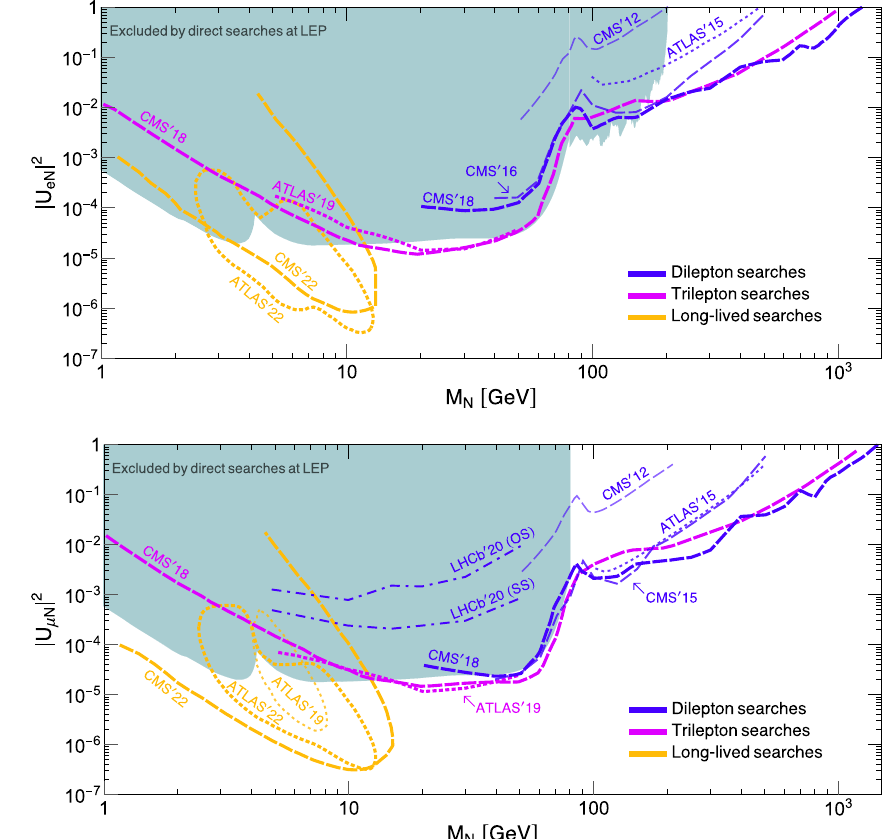
Fig. 2 Summary of direct HNL searches performed at the LHC so far, either by CMS (dashed), ATLAS (dotted) or LHCb (dot-dashed), and group by colors for different kind of searches as given in Table 1. In the upper (lower) panel a single mixing scenario to electrons (muons) is assumed. Shadowed area cover the area excluded by direct searches at LEP. Notice that below 2 GeV and above (approx.) 100 GeV, bounds from meson decays and from non-unitarity of the lepton mixing [92] dominate respectively over current LHC bounds, although we do not show them explicitly for easier reading of the collider